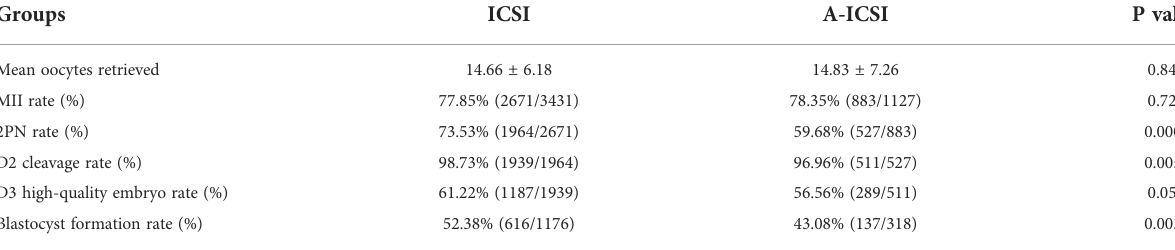
TABLE 5 Effects of A23187 activation on embryonic development after ICSI cycles.